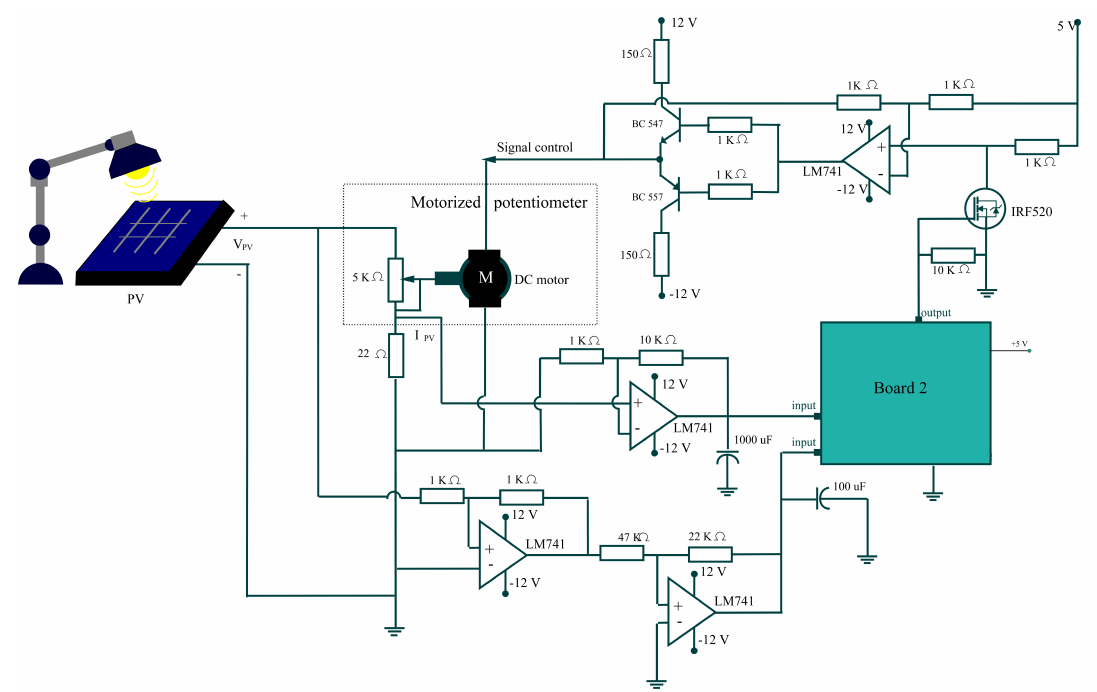
Figure A2. Electronic circuit for PV outputs’ data processing and control signal